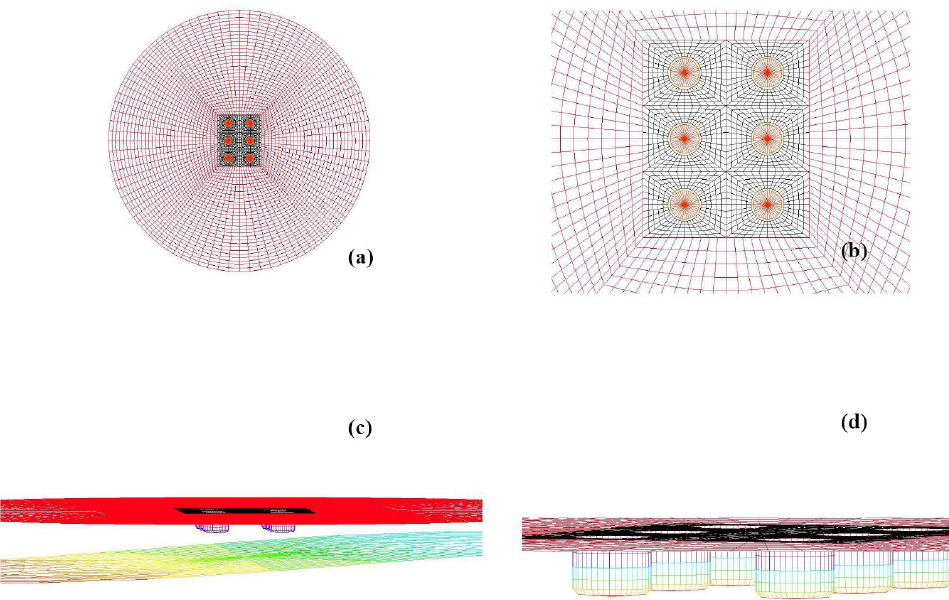
Figure 12. Computational grid for a WEC array of 3 × 2 WECs: ( a ) plot of the whole mesh on the free surface, ( b ) zoom in the subregion of floaters, ( c , d ) 3D view of the mesh in the vicinity of the WECs.